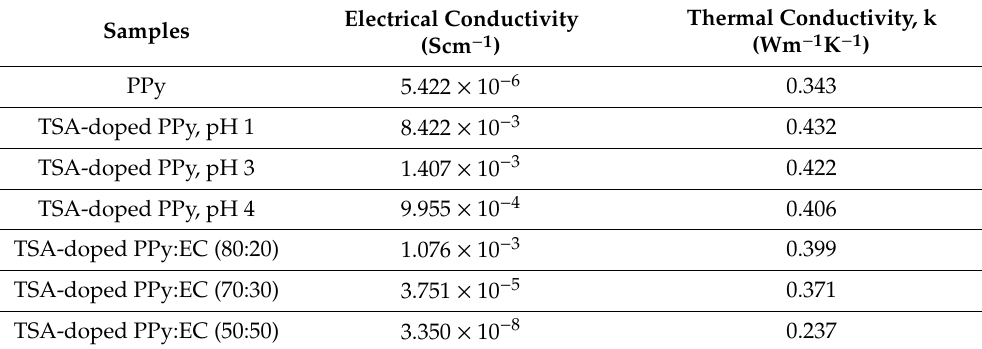
Table 1. Thermal conductivity and electrical conductivity of the nanocomposites synthesized [54].